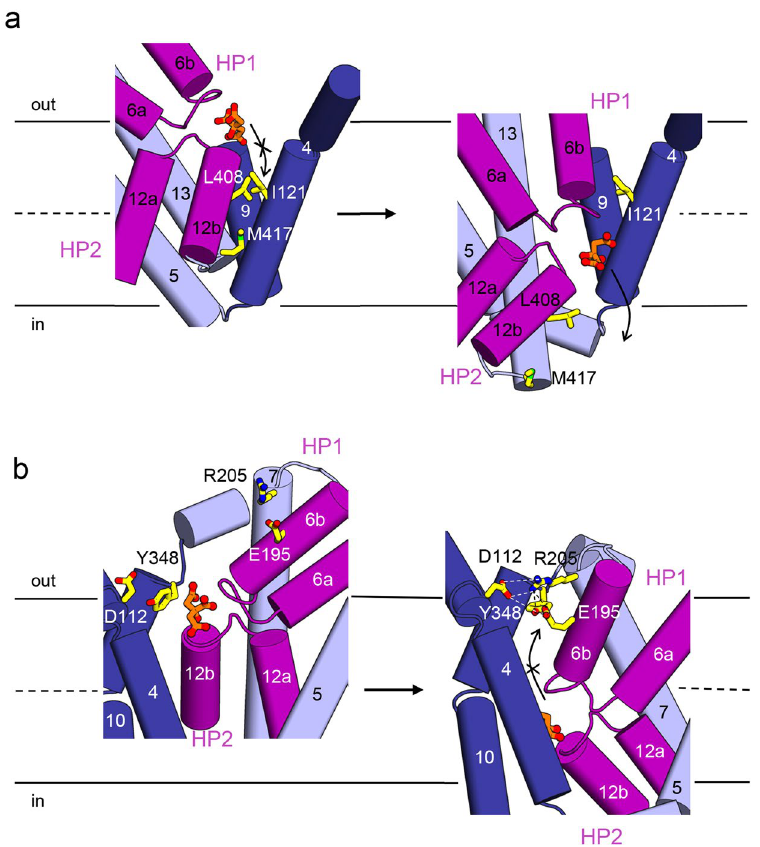
Figure 5. Alternating access mechanism of the Kp CitS. ( a ) In the outward-facing conformation, the transport pathway is blocked by I121, L408 and M417. In the inward-facing conformation, these residues move and citrate is released to the cytoplasm. The citrate is shown in orange and red. The release of citrate in the inward-facing conformation is marked by a black arrow. ( b ) Role of the polar residues in the alternating access mechanism. In the inward-facing conformation, D112, E195, R205 and Y348 form a salt bridge network at the membrane/ periplasm interface, by virtue of which the substrate transport pathway is open only towards the cytoplasm. The view is rotated by 30 degrees along the vertical axis from that of ( a